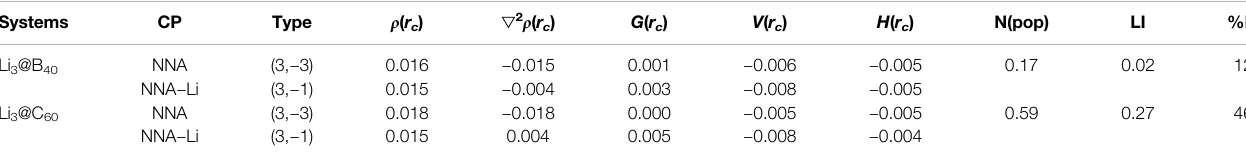
TABLE 1 | Electron Density [ ρ (r c )], Laplacian of Electron Density [ ∇ 2 ρ (r c )], Kinetic Energy Density [G(r c )], Potential Energy Density [V(r c )], Total Energy Density [H(r c )], Basin